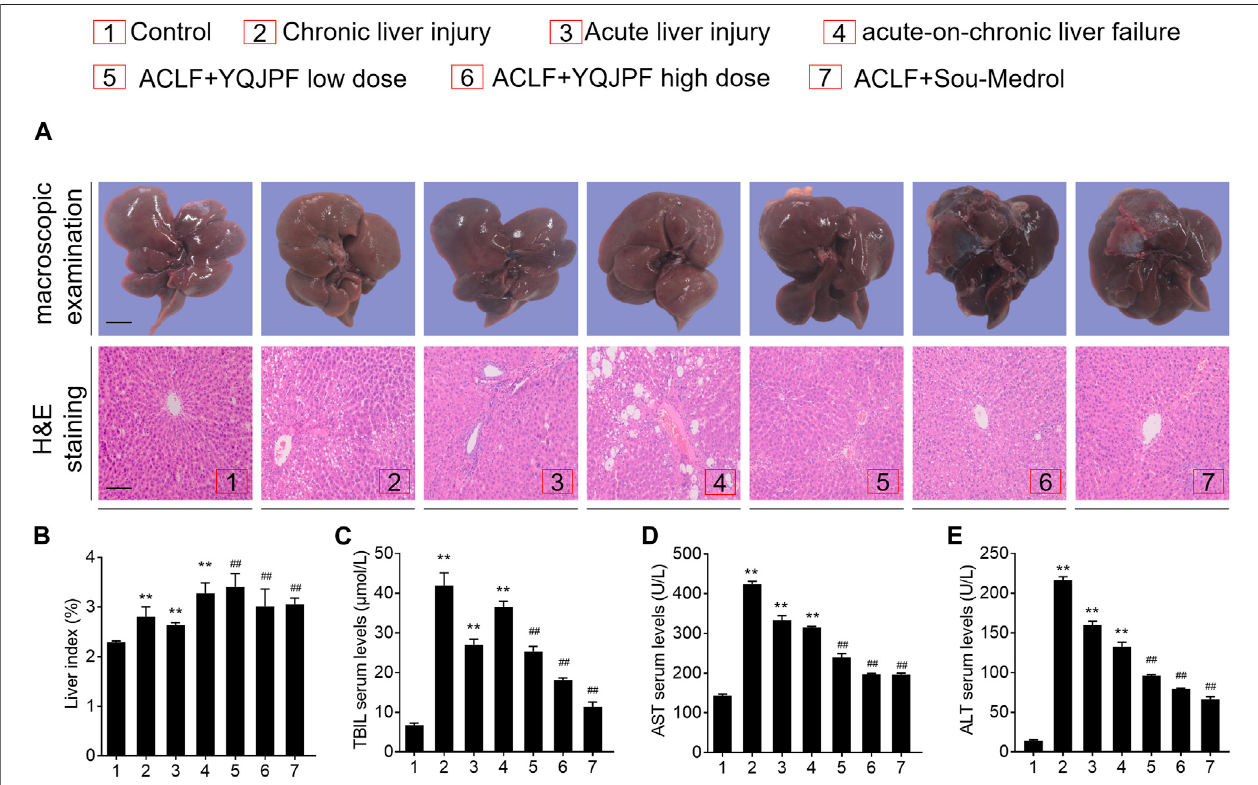
FIGURE 3 | YPJPF alleviated liver injury in vivo. (A) Ratio of liver weight and body weight. (B – D) TBIL, AST, and ALT levels in serum. (E) Representative pictures of liver tissues and photograph of H&E-stained sections (Scale bars, 100 μ m). Data are expressed as mean ± SD ( n (cid:2) 8) *vs. control group, *vs. ACLF group; * p < 0.05, ** p < 0.01; # p < 0.05, ## p <